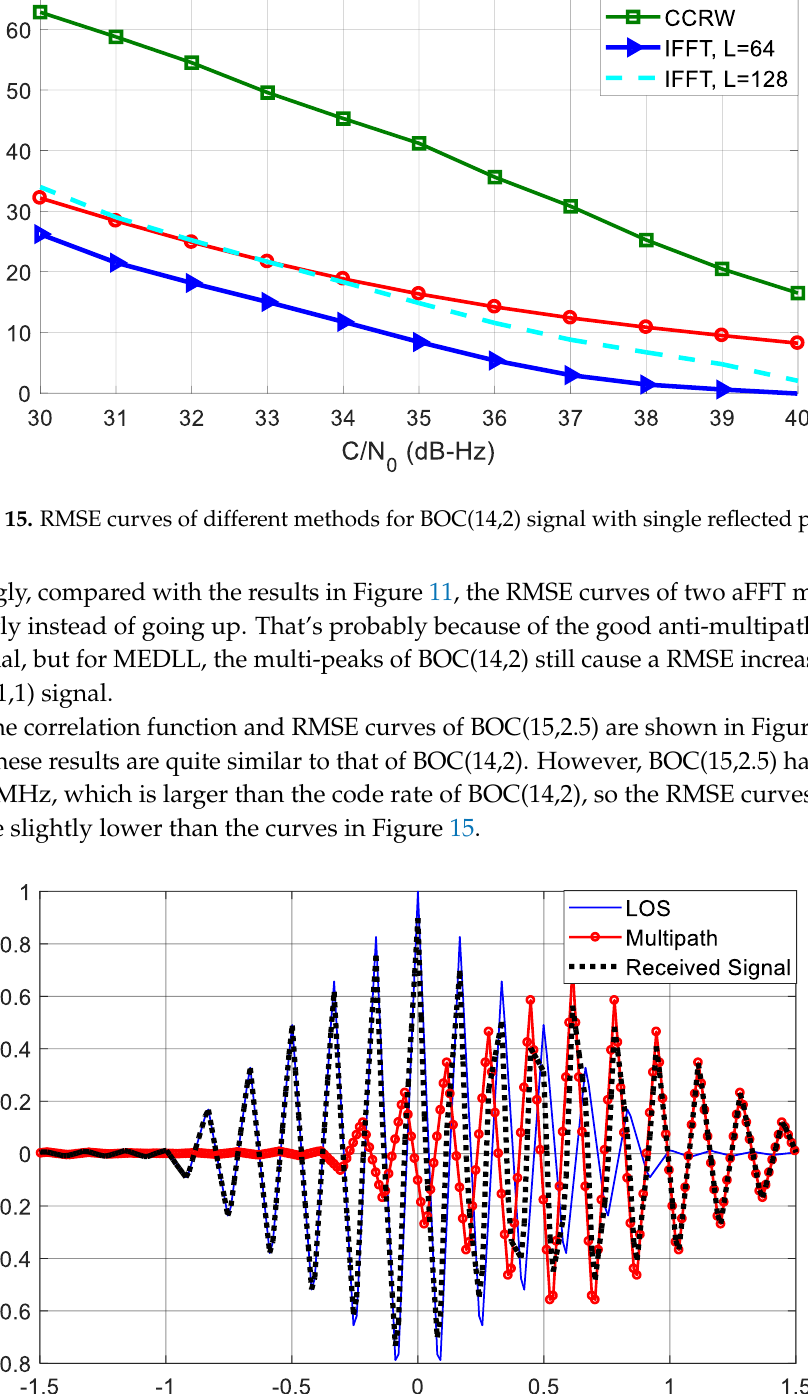
Figure 14. Correlation function of BOC(14,2) signal in the presence of single multipath component.